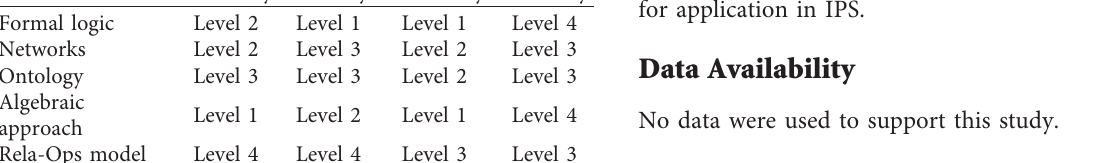
Table 6: Comparison between methods for knowledge representation.